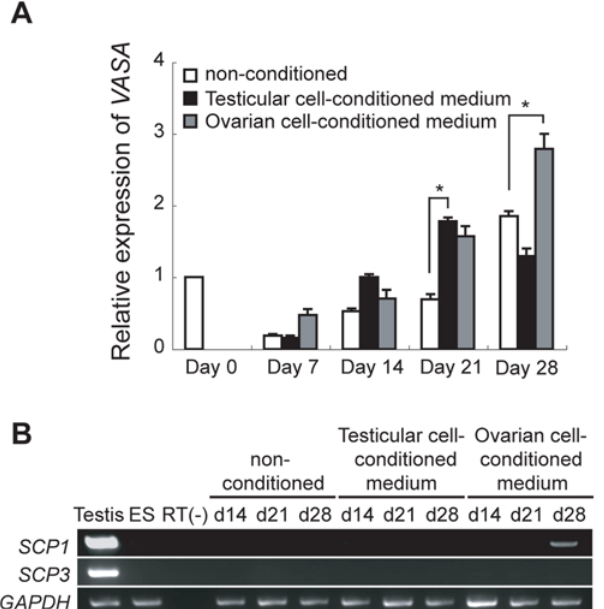
Figure 4. The effect of mouse testicular and ovarian cell- conditioned media on germ cell differentiation in monkey EBs. (A) The VASA expression in ES cells (day 0) and EBs (days 7, 14, 21, and 28) in non-conditioned medium, testicular, or ovarian cell-conditioned medium was compared using quantitative RT-PCR. The expression levels of VASA in treated EBs are shown relative to VASA expression in ES cells (day 0). The data represent the means 6 standard deviation from triplicate PCR assays. ( B ) Expression of SCP1 and SCP3 in monkey testis (5 years old), ES cells (ES), and developing EBs (days 14, 21, and 28) in non-conditioned medium, testicular, or ovarian cell-conditioned medi- um was examined using RT-PCR. GAPDH was used as an internal control. Statistical significance was tested by Student’s t -test. Asterisk, P , 0.01.